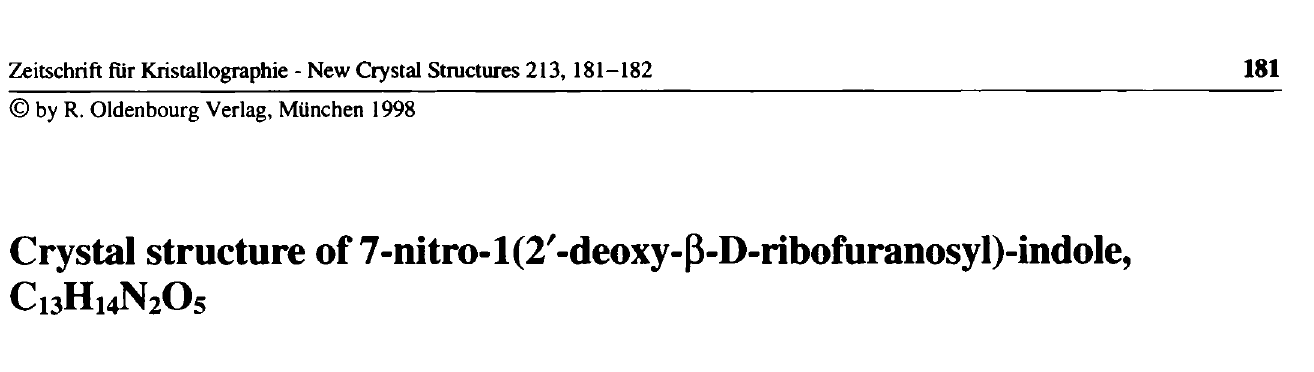
Table 1. Parameters used for the X-ray data collection Crystal: